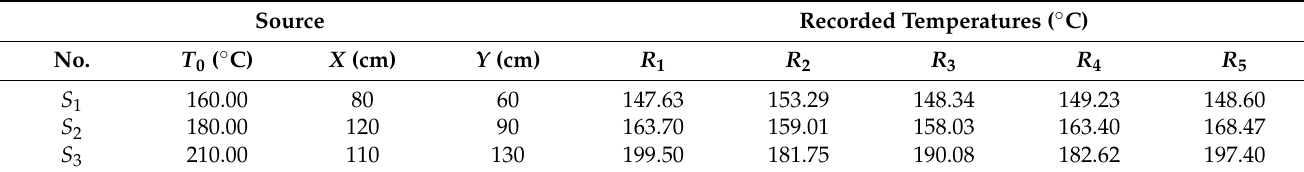
Table 1. Heat source locations and their recorded